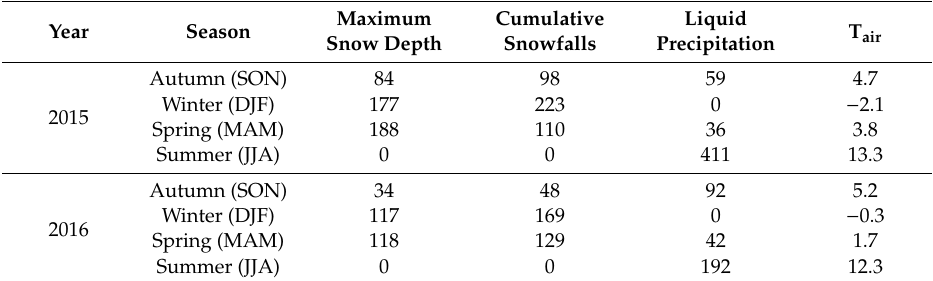
Figure 2. Snow depth (cm), liquid precipitation (mm), and air temperature (T air ) recorded by the AMS of Weissmatten in the experimental period 2015–2016. Table 1. Maximum snow depth (cm), cumulative snowfalls (cm), liquid precipitation (mm), and mean air temperature (T air , ◦ C) recorded by the AMS of Weissmatten (2038 m) in the experimental period 2015–2016.